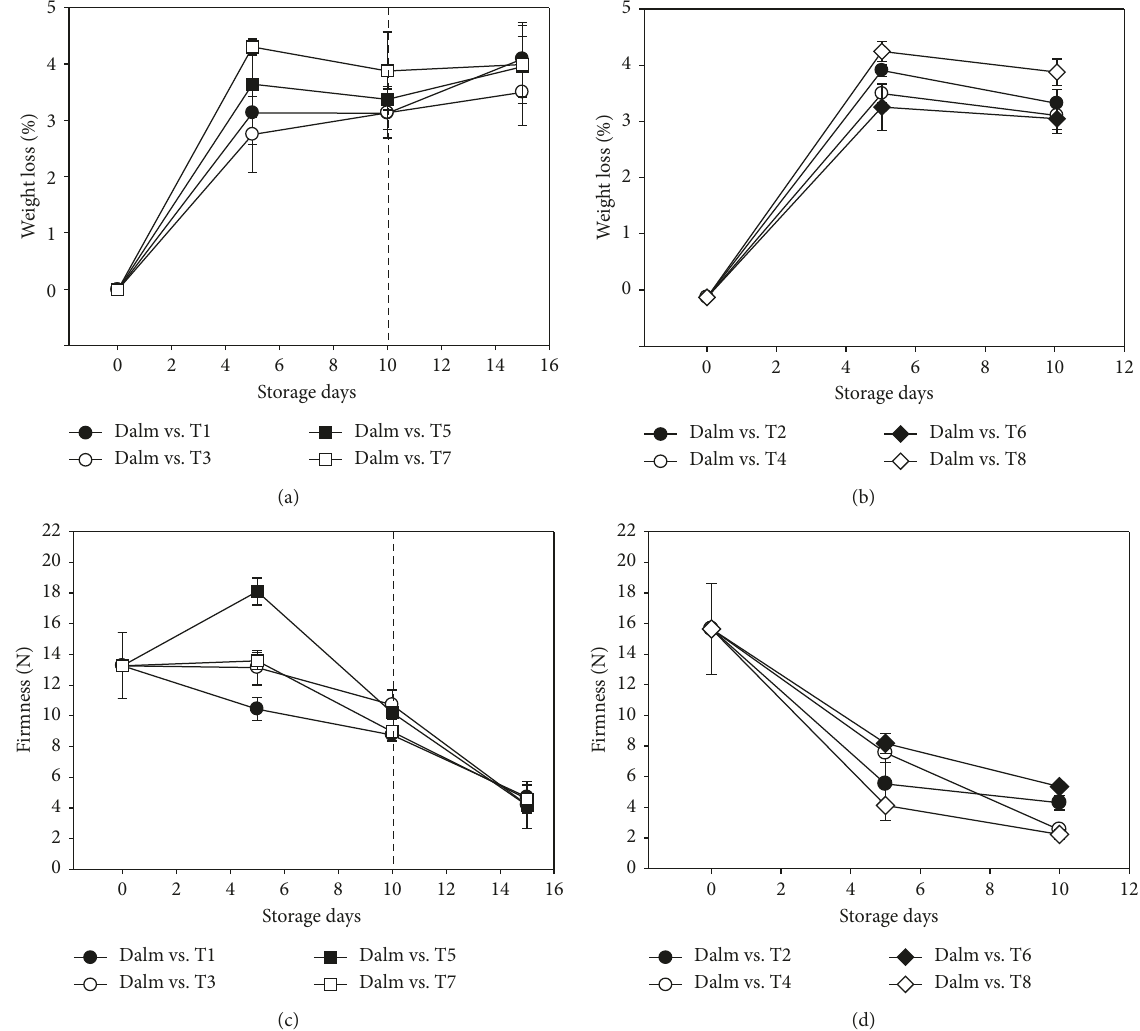
Figure 1: Stenospermocarpic mango “Ataulfo” fruit coated with different treatments: T1 and T2 (coating of banana “Pear”), T3 and T4 (coating of soursop), T5 and T6 (coating of stenospermocarpic mango “Ataulfo”), and T7 and T8 (control fruit: uncoated). (a and c) Fruit stored at 10